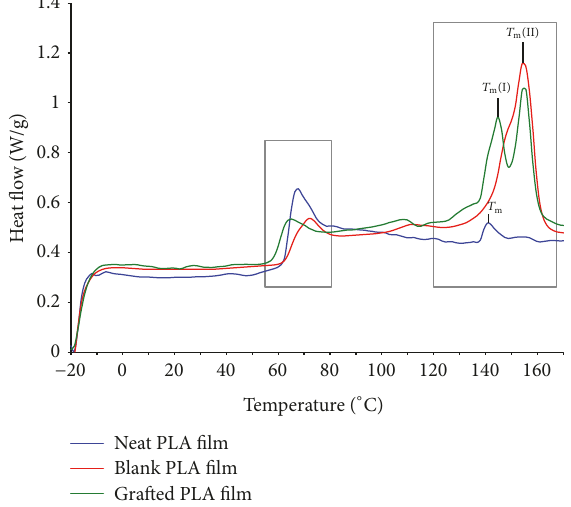
Figure 8: DSC thermograms (1st heating curve) of neat, blank, and grafted PLA